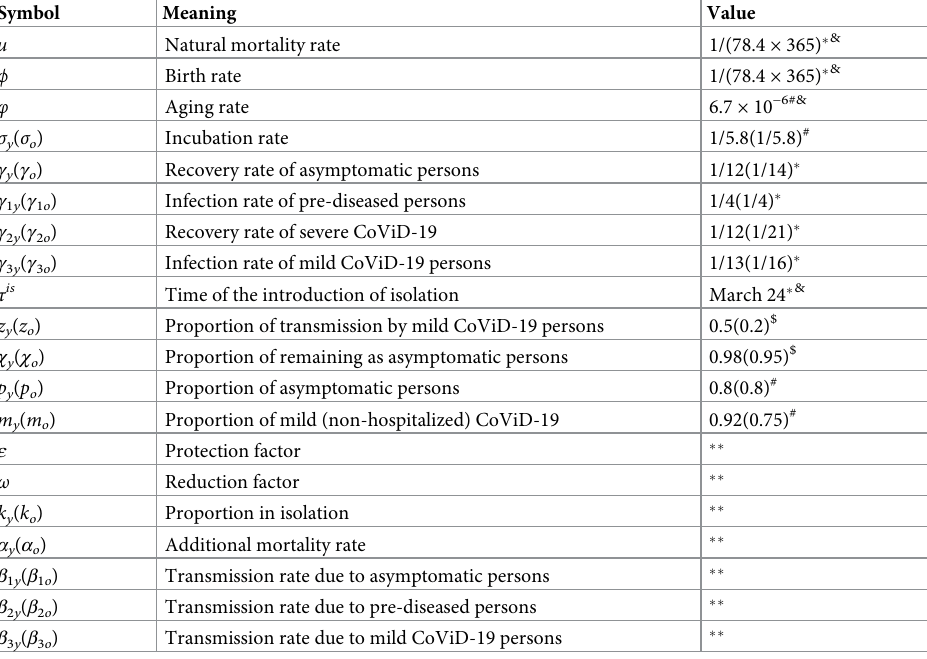
Table 2. Summary of the reduced model parameters ( j = y , o ) and values (rates in days − 1 , time in days and propor- tions are dimensionless). Some values are calculated ( # ) or assumed ( $ ) or obtained from the liteature ( � ) or estimated ( �� ). The values ( & ) correspond to S ã o Paulo State. For Spain, ϕ = μ = 1/(83.4 × 365) days − 1 , φ = 1.14 × 10 − 5 days − 1 , and τ is is March 16.